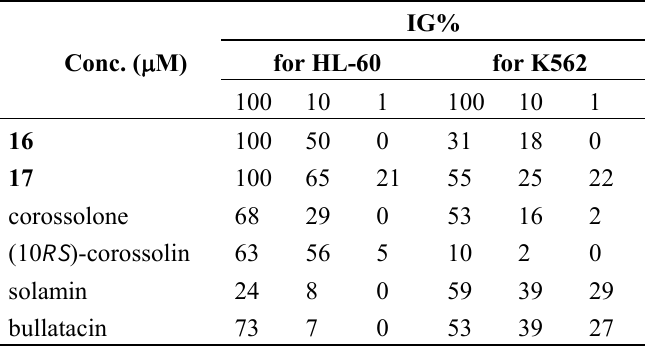
Table 2. In vitro testing against the HL-60 and K562 cell